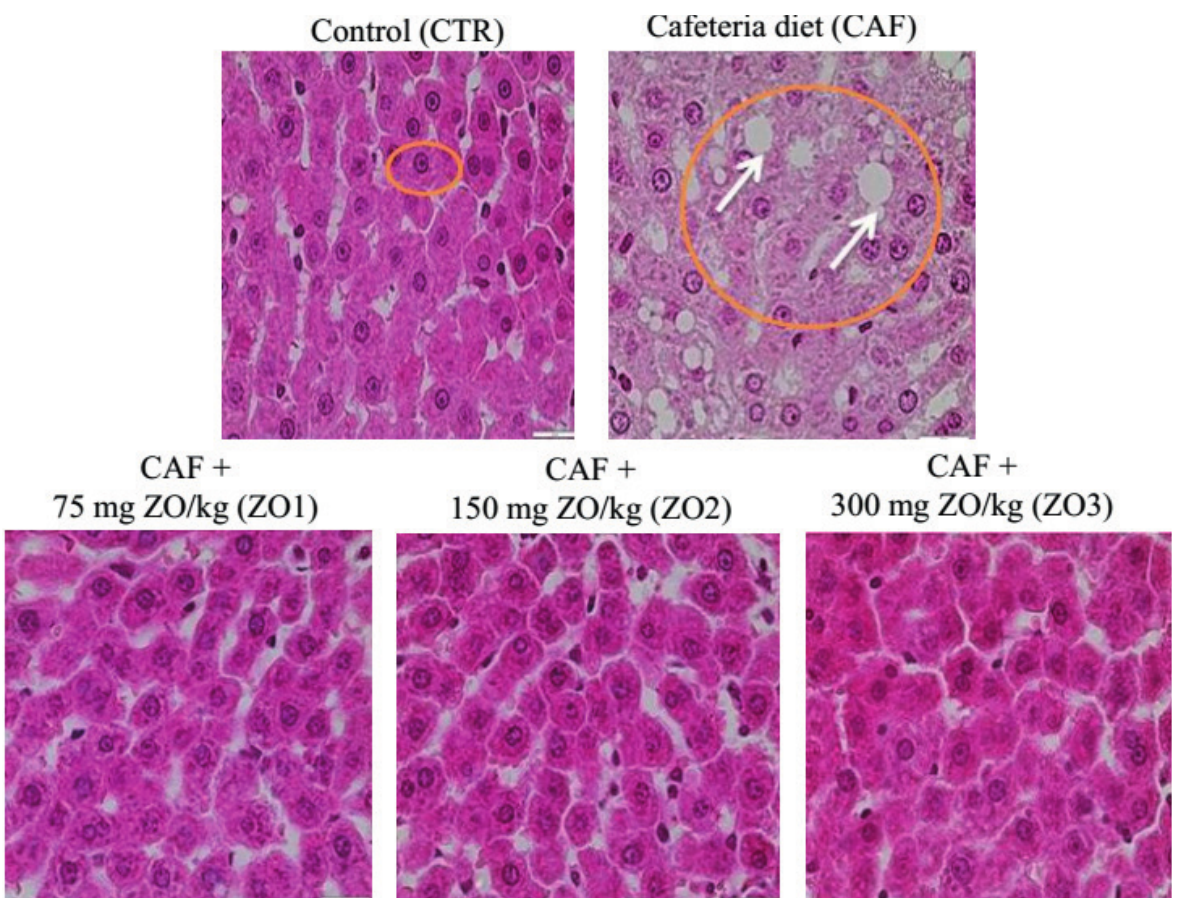
Figure 2 - Histological images of the liver of animals from different experimental groups. White arrows show fat deposition in the liver. CtR: control fed a commercial chow; CAF: cafeteria diet; ZO: formulation containing ginger. Scale bar, 20